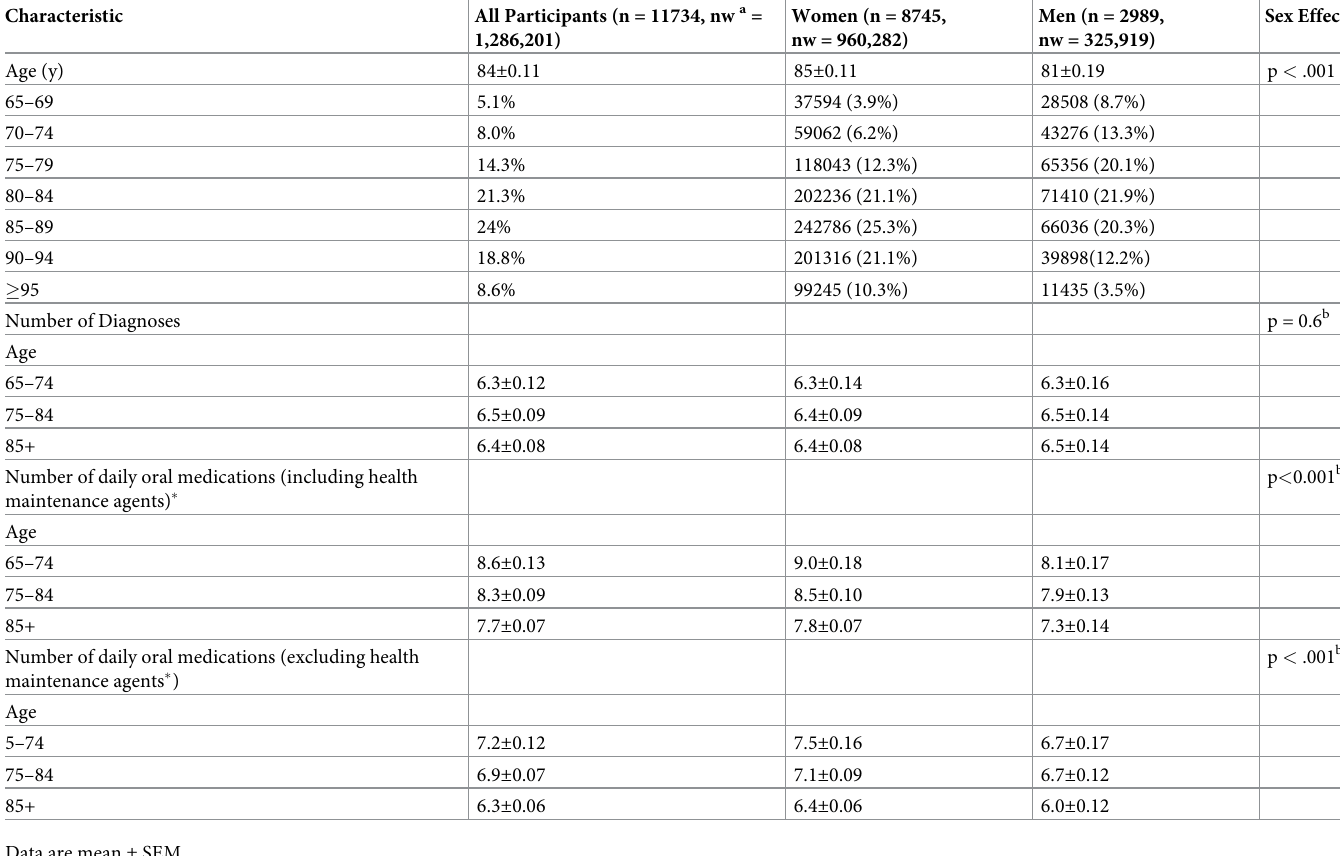
Table 1. Characteristics of long-stay nursing home residents aged 65 and older. Characteristic